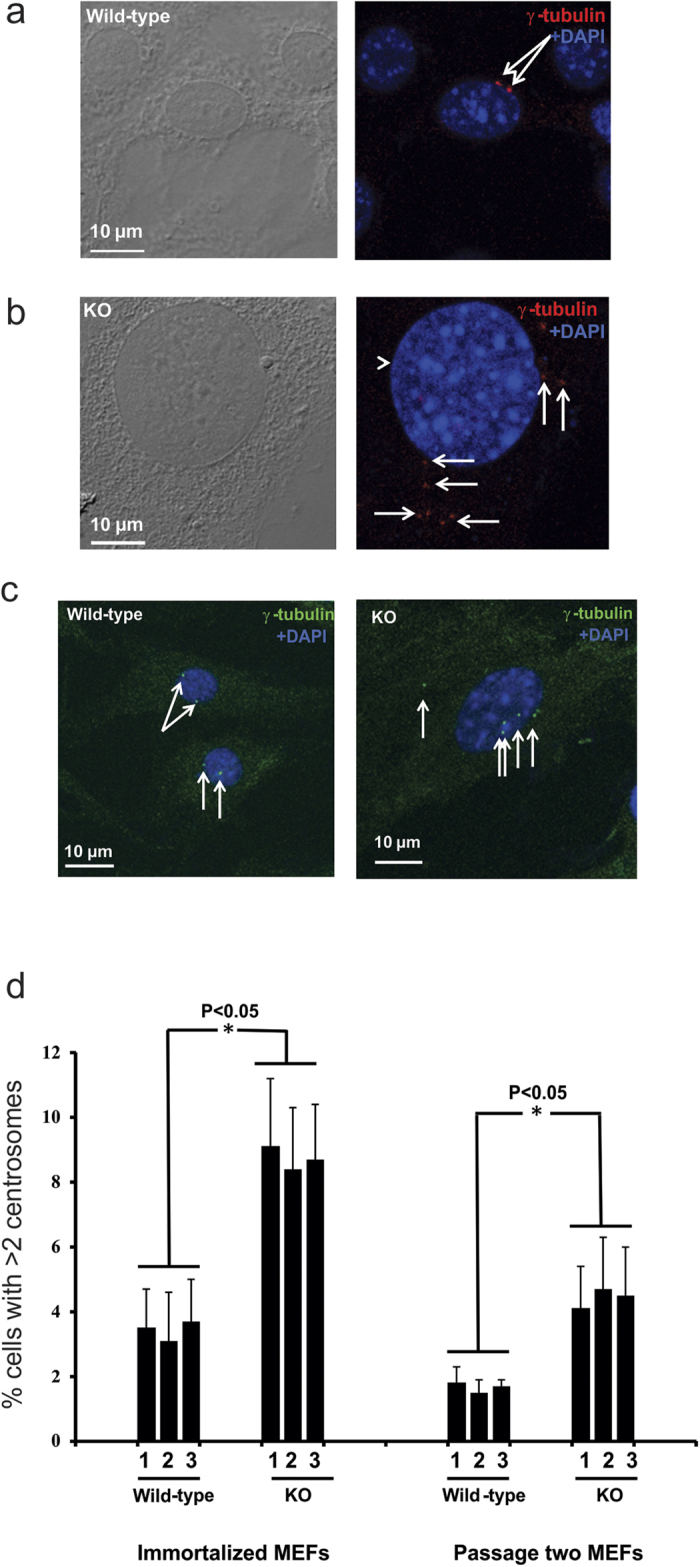
Multiple centrosomes in the Spag6-deficient (KO) MEFs.(a) Representative images of immortalized wild-type MEFs double stained with a monoclonal anti-γ tubulin antibody. Only two centrosomes were present in each wild-type MEFs. (b) Representative images of immortalized Spag6-deficient MEFs showing multiple centrosomes, and these centrosomes are not localized at the correct position. Frequently, abnormal large nuclei was seen in the Spag6-deficient MEFs (The arrow-heads point to abnormally large nuclei). (c) Representative images of passage two wild-type (left) and Spag6-deficient (right) MEFs stained with anti-γ tubulin antibody. Only two centrosomes were present in each wild-type MEF, but multiple centrosomes were observed in some Spag6-deficient MEFs. White arrows point to the centrosomes. (d) Quantitation of multiple centrosomes (>2) in primary and immortalized wild-type and Spag6-deficient MEFs. 500 cells were counted for each cell line, and three wild-type and three KO MEFs were analyzed. The percentages of cells with multiple centrosomes are significantly higher in the Spag6-deficient MEFs. *p < 0.05.